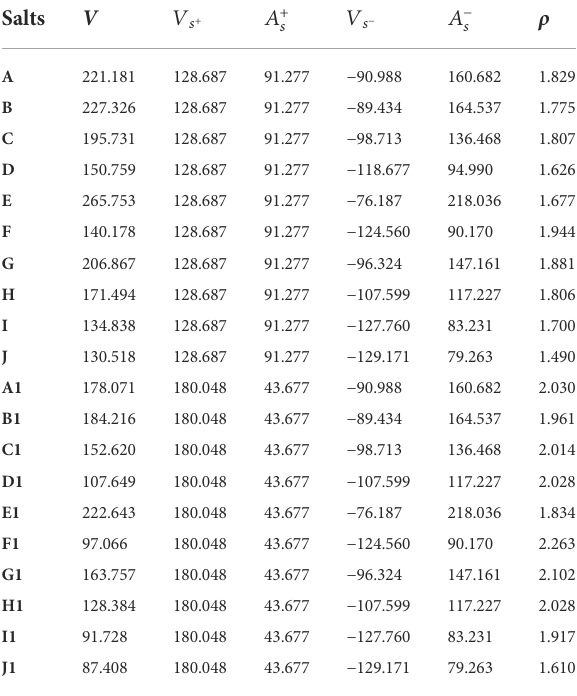
TABLE 1 The crystal densities (g cm − 3 ) and volumes (cm 3 mol − 1 ) of N 5 + (A-J) and O